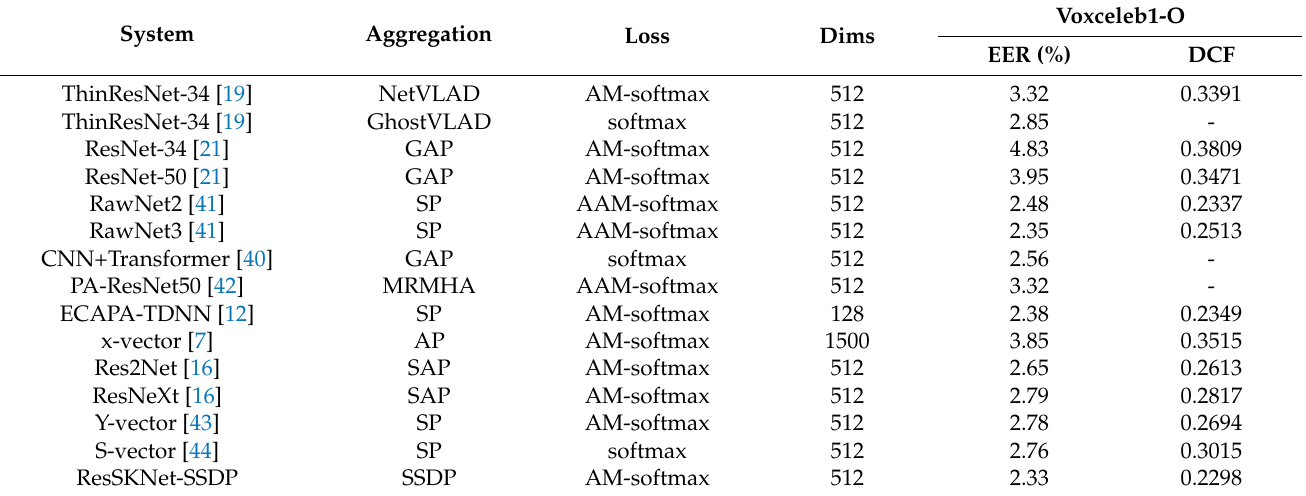
Table 6. Results of different systems on the Voxceleb1-O test set.